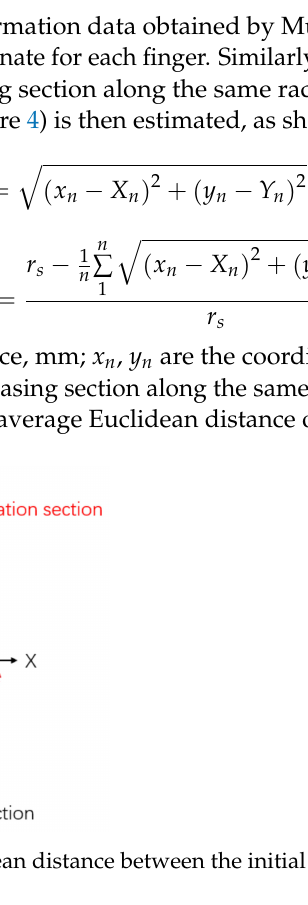
Figure 3. Casing deformation section G1701 ( left ) from Guandong Block and W12-3 ( right ) from Weiyuan block with the same minimum inner diameter but the different profiles.